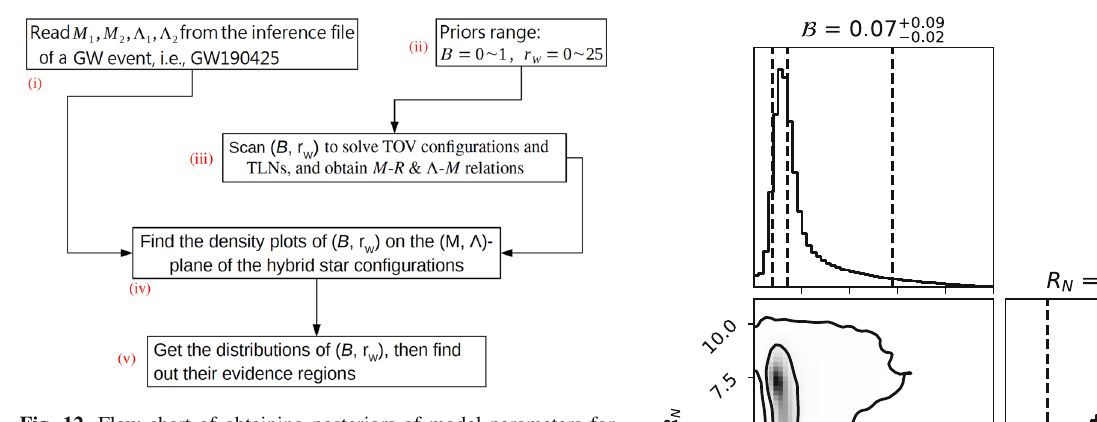
Fig. 12 Flow chart of obtaining posteriors of model parameters for the hybrid stars from the posteriors of PE for a particular GW event, such as GW190425. Here, Box (i) is to obtain the headcounts of the PE posterior of GW190425; Box (ii) and (iii) are to find the corresponding ( B , r ) for each headcount labelled by ( M ,Λ) from mass–radius and W TLN–mass relations; and Box (iv) and (v) are to use the results in the previous step to obtain the density plot of ( B , r W ) on the ( M ,Λ) -plane, and their corresponding evidence regions and marginal distributions. See also the discussions in the main text